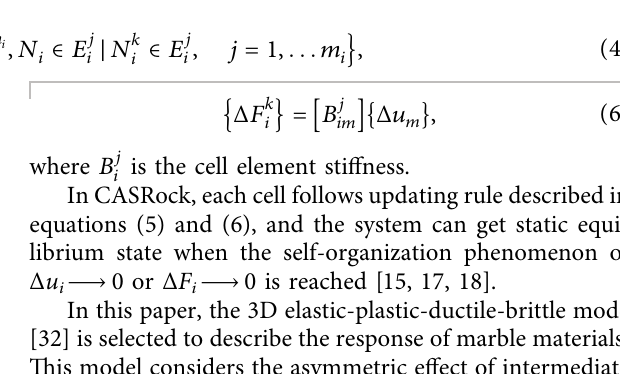
Figure 2: View of the specimens: (a) intact specimen, (b) specimen containing a single crack, and (c) specimen containing multiple